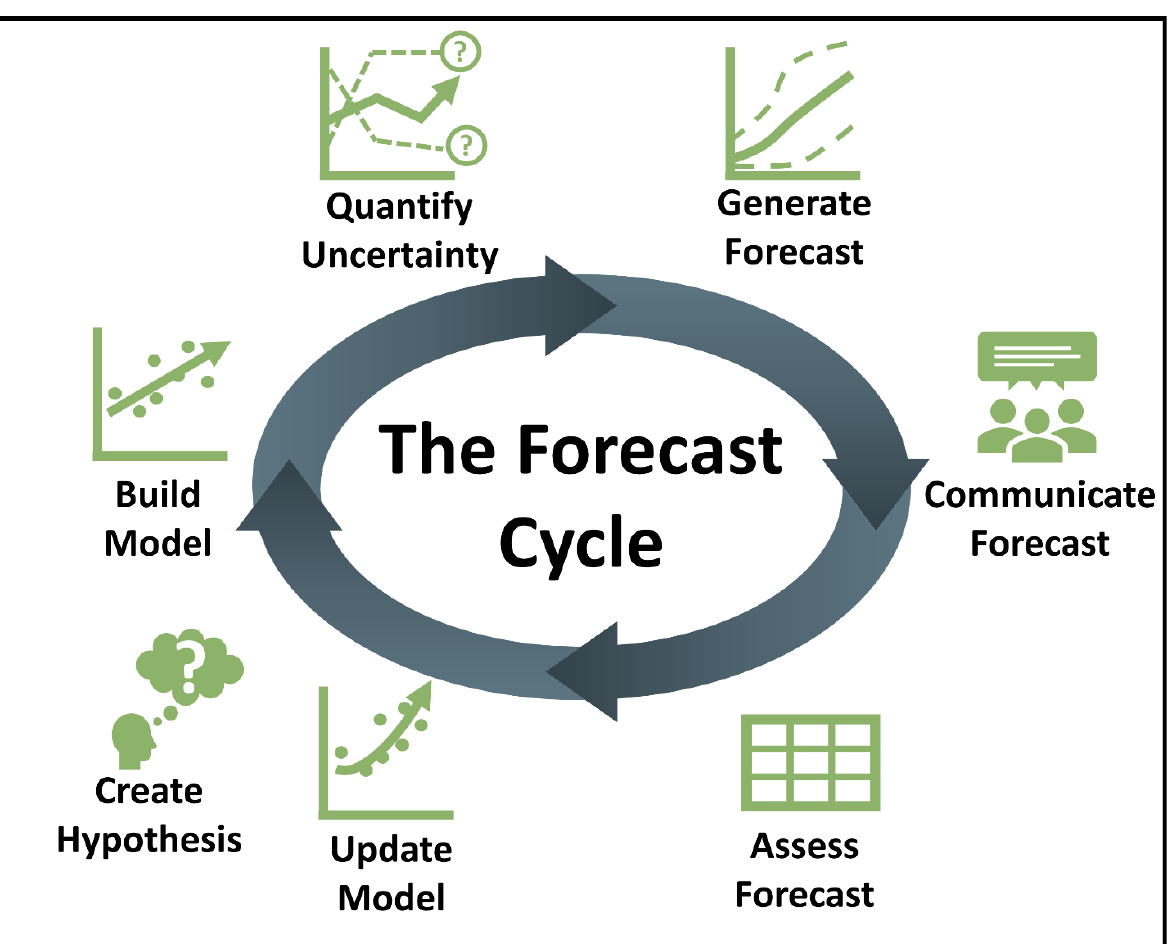
Figure 1. Schematic of the iterative, near-term ecological forecasting (INTEF) cycle used in the module to teach ecological forecasting to students.